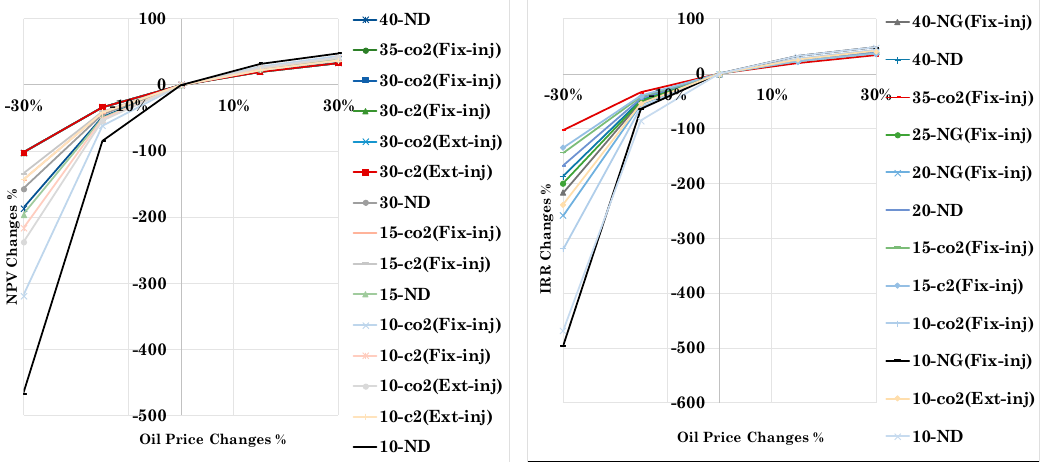
Figure 33. Changes in NPV and IRR coming from variation in fracking costs.